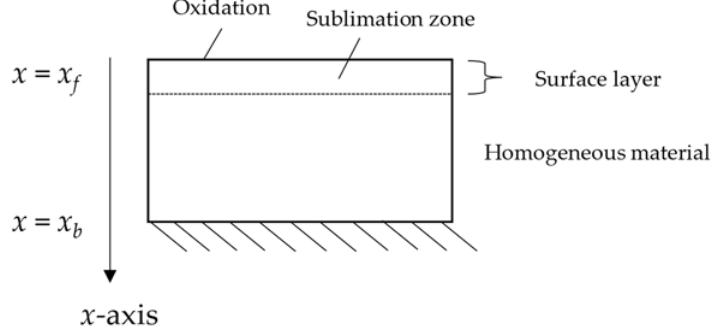
Figure 2. Relevant ablation processes occurring in SiC.